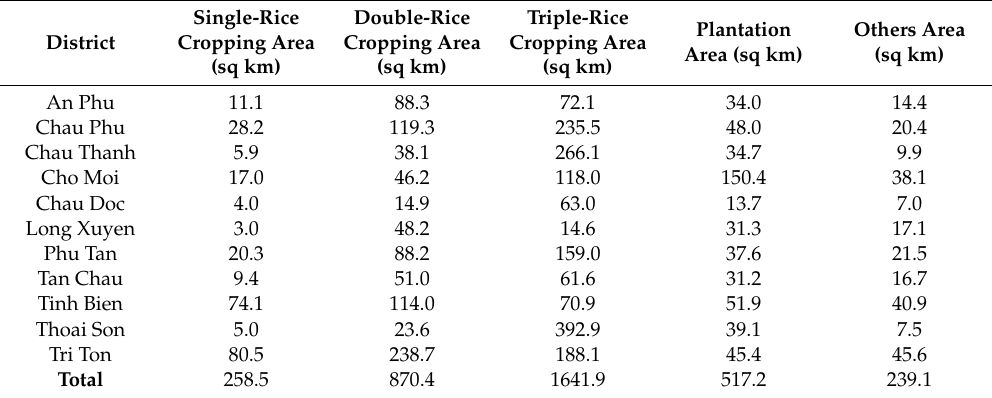
Figure 11. ( a ) Sentinel-1A-based land cover classification of An Giang province. ( b ) Distribution of LULC classes in An Giang. Table 2. District level distribution of various land use/land cover (LULC) classes.